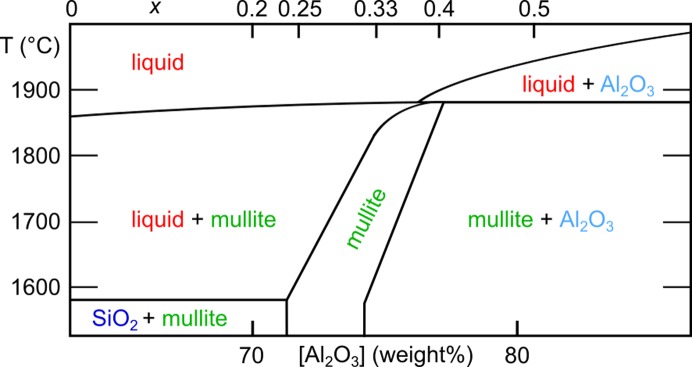
Part of the SiO2–Al2O3 phase diagram adapted with permission from Klug et al. (1987 ▸). Copyright (1987) The American Ceramic Society.